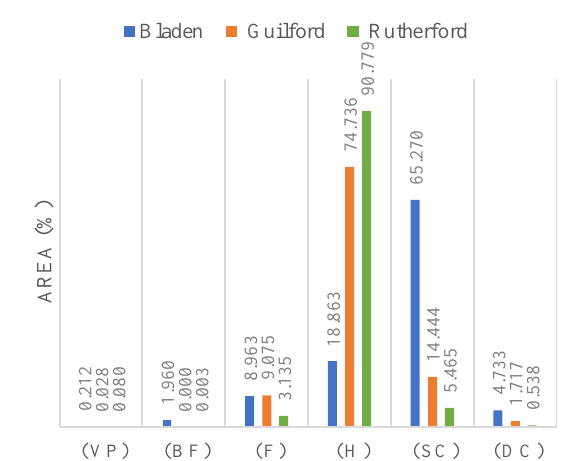
Figure 3. Food deserts: 2008-2019 average shares of the farmland area under alternative uses. Notes: VP = vegetables & produce, BF = berries & fruits, F = fallow, H = hay, SC = single season, DC = double season.